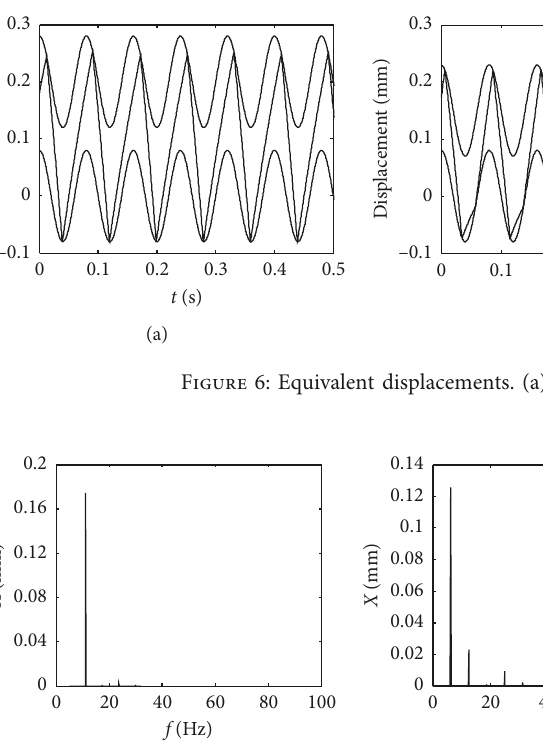
Figure 7: Frequency spectrogram. (a) j